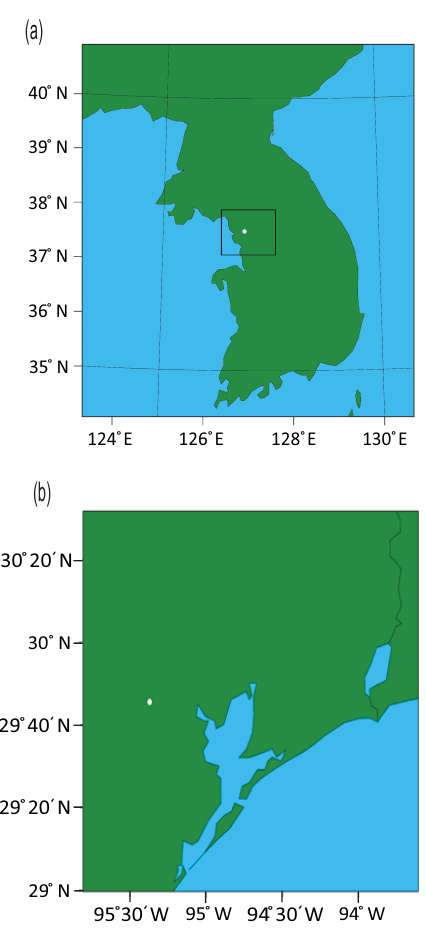
Figure 2. (a) The domain (marked by the rectangle) used in simu- lations for the Seoul case. The small white circle marks the center of Seoul. (b) The domain used in simulations for the Houston case. The small white circle marks the center of Houston.